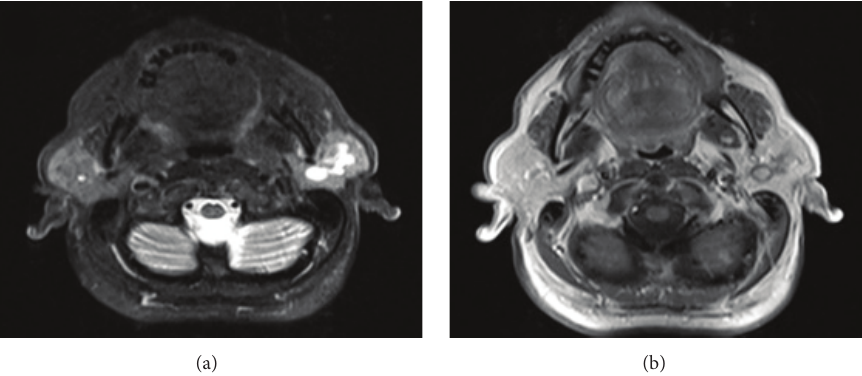
Figure 1: (a) In axial T2 FS magnetic resonance imaging (MRI) a homogeneous hyperintense lesion was seen in superficial and deep lobes of the left parotid gland. (b) In contrasted axial T1 sections a heterogeneous dense enhancement was seen in the center of the mass.